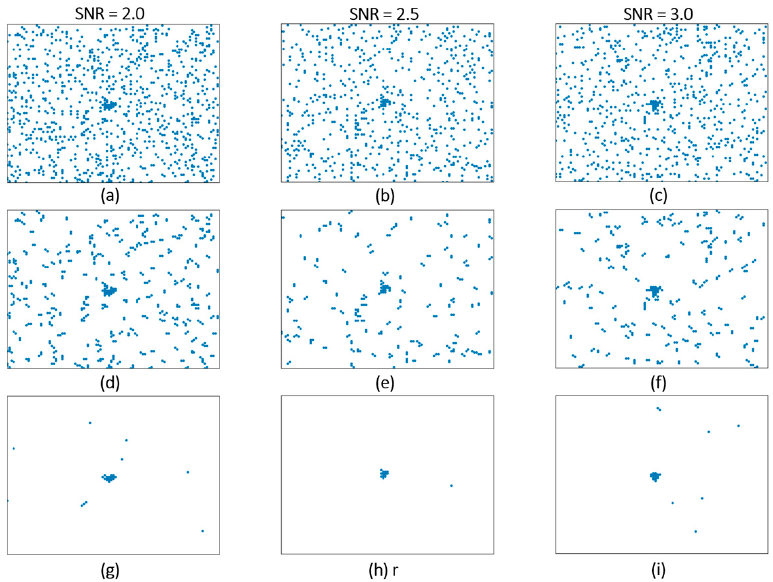
Figure 8. Experimental results from 0.5 to 1.5 dB: ( a – c ) are the original images. ( d – f ) are the results of 8-neighbour. ( g – i ) the results of 4-neighbour.